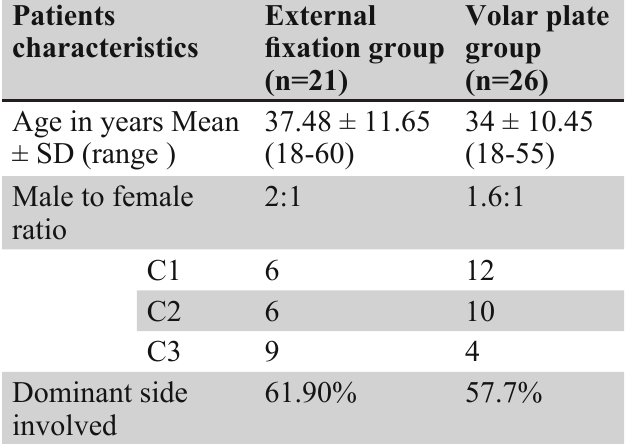
Table 1. Demographic characteristics of patients